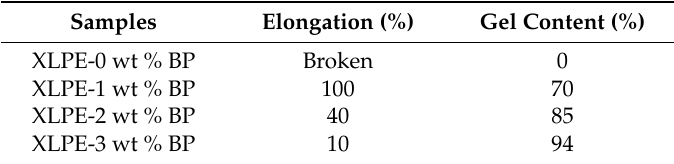
Table 1. Thermal elongation and gel content of materials.